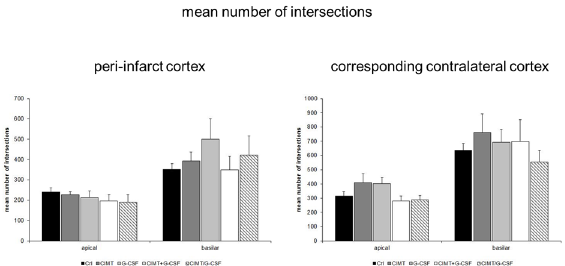
Fig 5. Intersection analysis of Golgi Cox-impregnated layer V pyramidal neurons in the peri-infarct cortex and in the corresponding contralateral cortex. No significant differences in the mean number of intersections of apical and basilar dendrites between the various experimental groups were detectable (Values are expressed as mean number of intersections ± SEM).